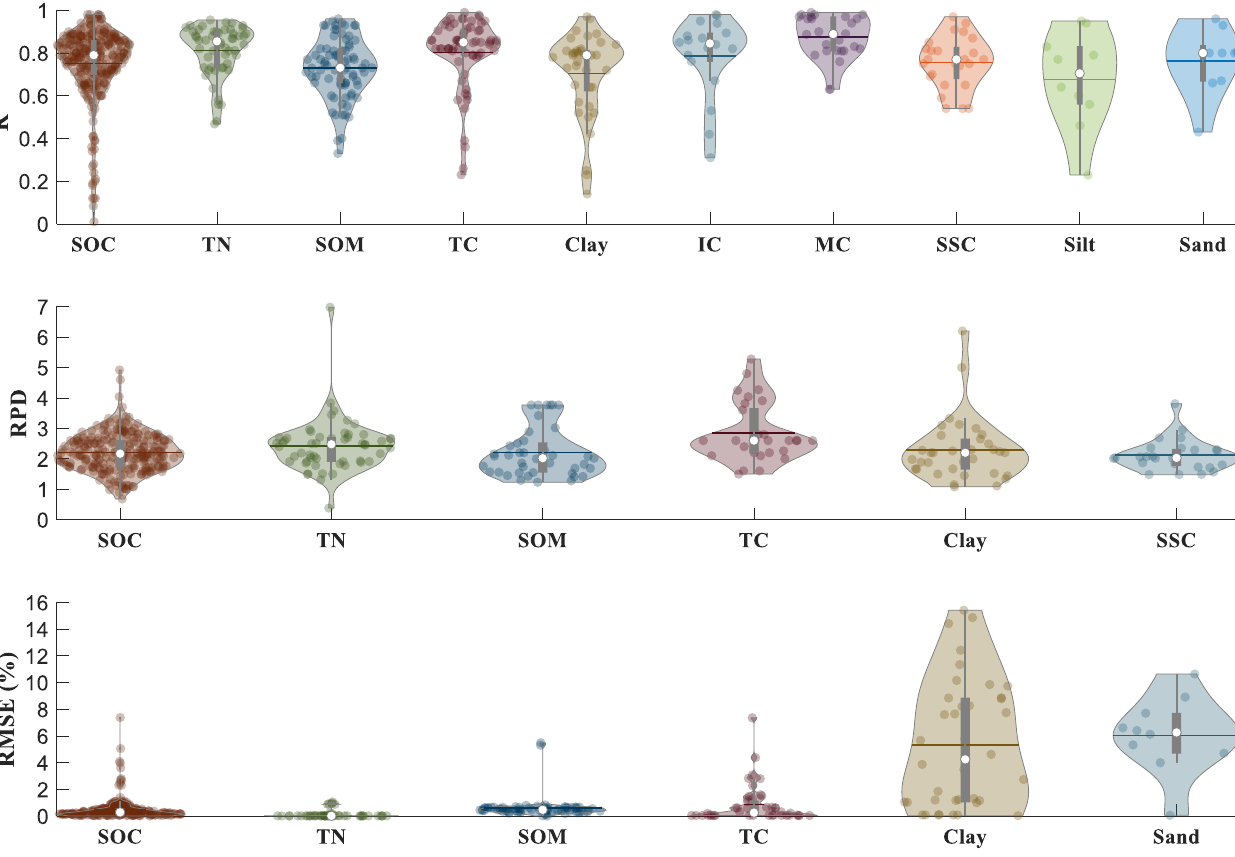
Figure 7. Statistical measures representing the proportion of variance for different soil properties .